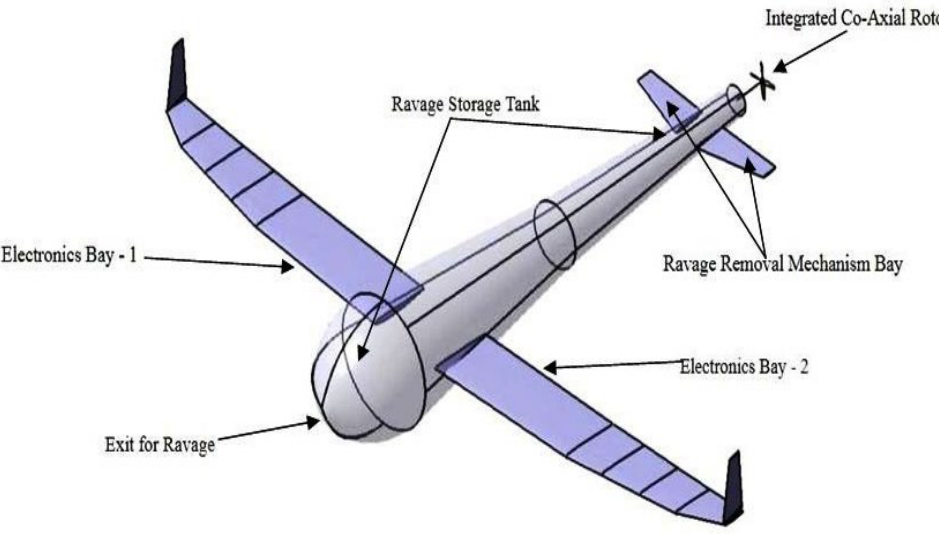
Figure 42. Components and arrangements of UAV at the stage of removal of ravage.